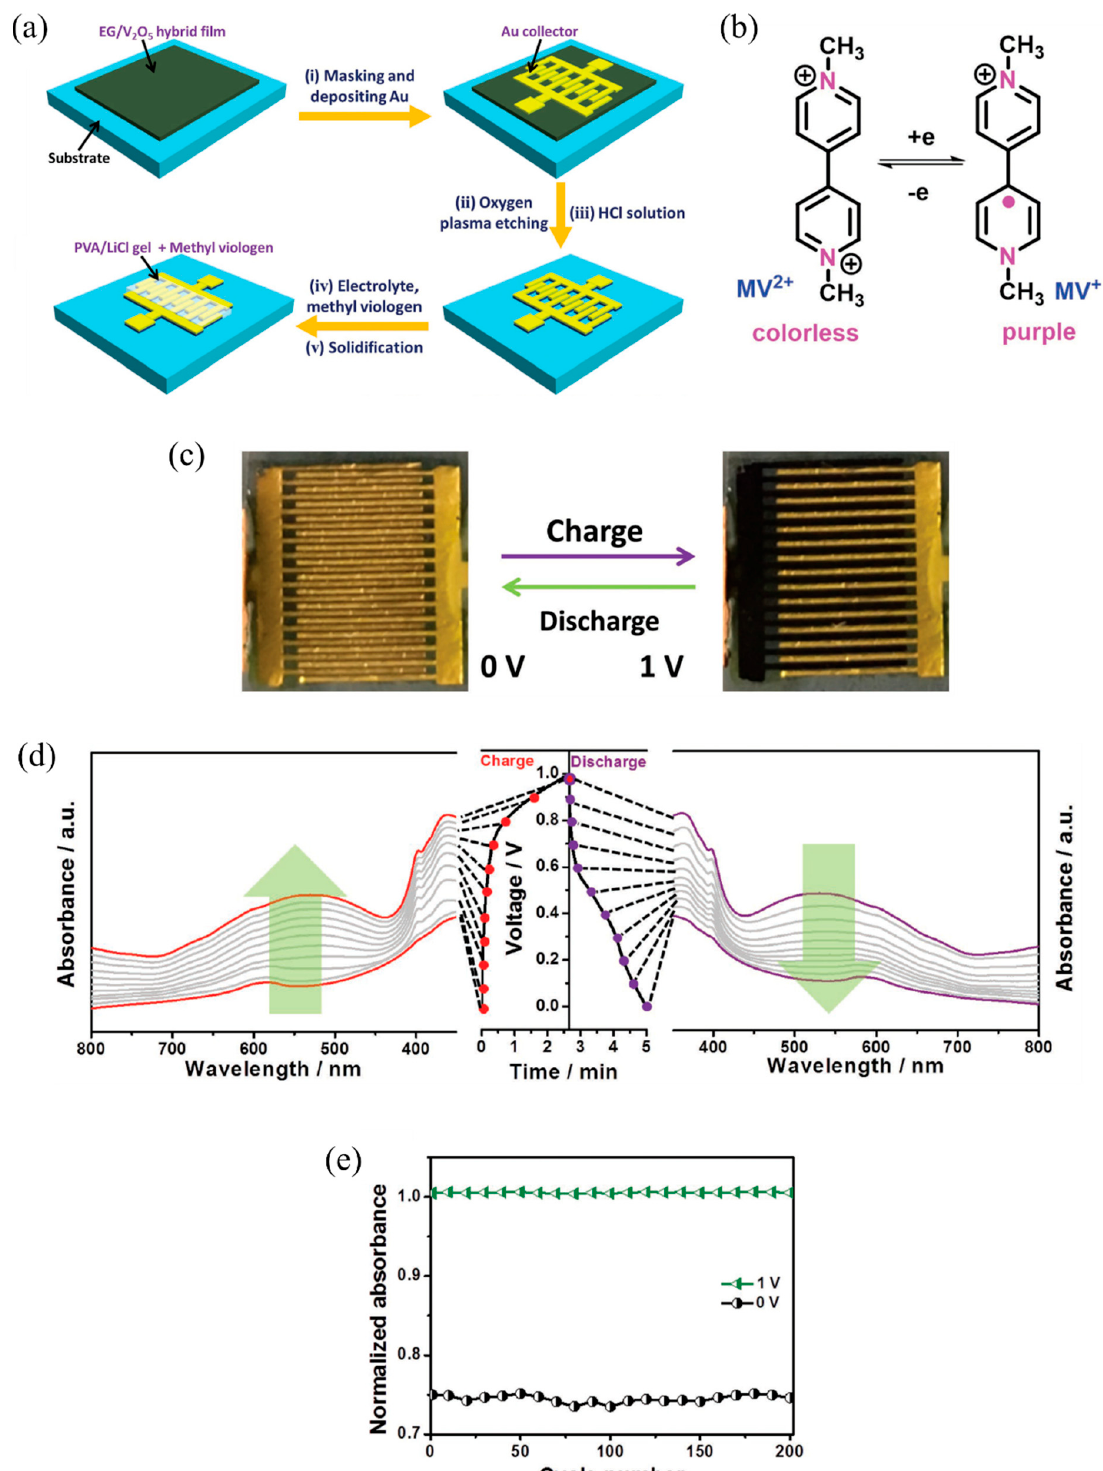
Figure 11. ( a ) The fabrication of an electrochromic microsupercapacitor with in-plane interdigitated electrodes. ( b ) The electrochromic mechanism of viologen. ( c ) Photographs of the reversible electrochromic effect of the microsupercapacitor during charge-discharge states. ( d ) The UV-VIS spectra of the electrochromic microsupercapacitor at different voltages at a current density of 0.015 mA cm − 2 between 0 and 1.0 V during a single charge-discharge cycle. ( e ) Cycle stability of the electrochromic effect for the microsupercapacitor showing the voltage-controlled absorbance changes at 550 nm between 0 and 1.0 V. Reprinted with permission from ref. [119] Copyright (2016) Wiley.